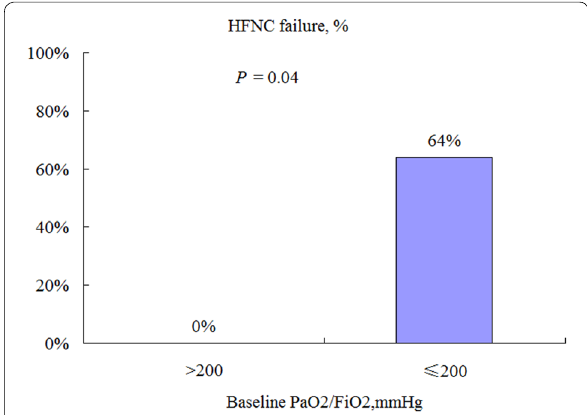
Fig. 2 HFNC failure rate in different groups stratified by PaO 2 /FiO 2